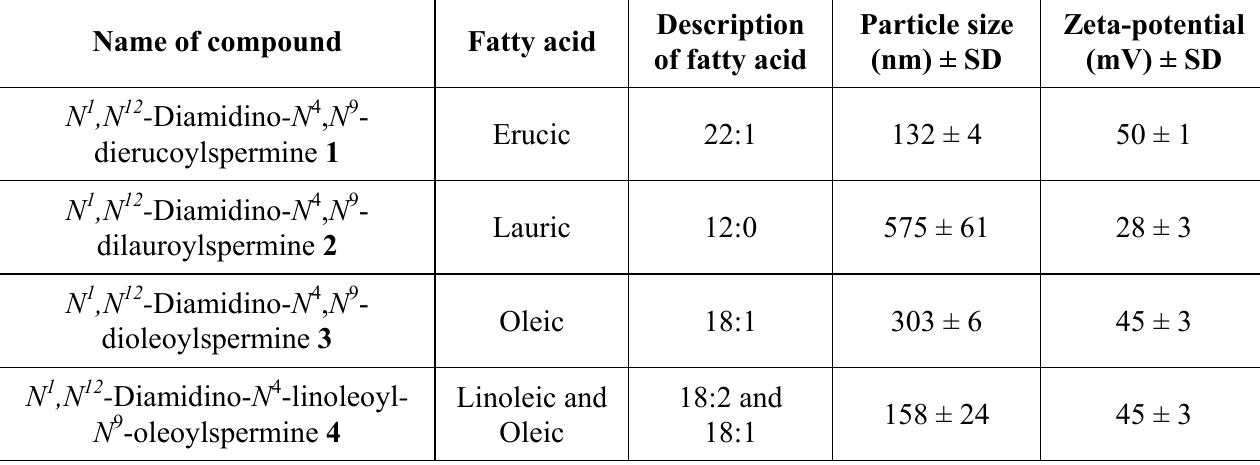
Table 1. N 1 , N 12 -Diamidine derivatives of different lipospermines. The fatty acids are described by two numbers separated by a colon, first the chain length and then the number of double bonds. Particle size and ζ - potential of guanidinylated lipospermines were measured at the cationic lipid/short interfering RNA (siRNA) ratios that showed best reduction in GFP